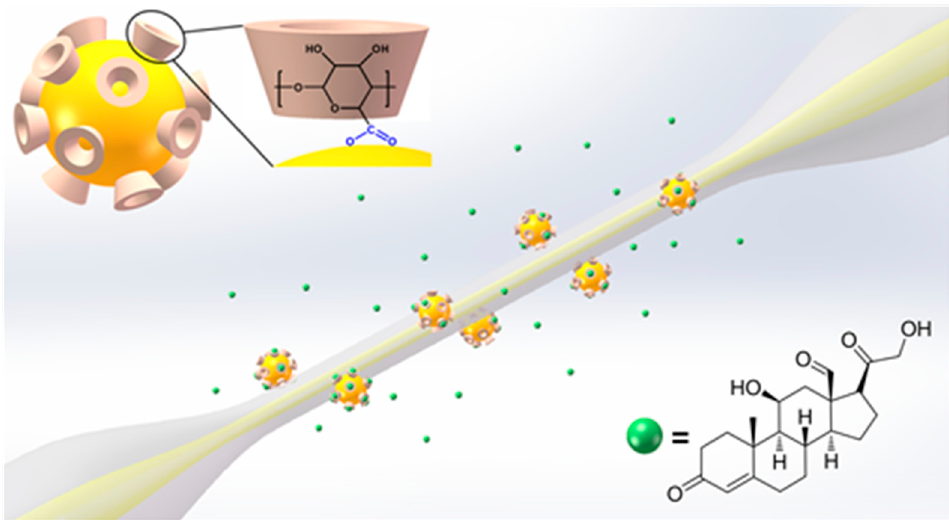
Figure 13. The schematic illustration of the β -CD-capped AuNPs based fiber-optic biosensor. (Inset1): The conjunction between β -CD molecule and AuNP surface. (Inset2): The molecular structure of cholesterol (Figure adapted with permission from reference [109]).